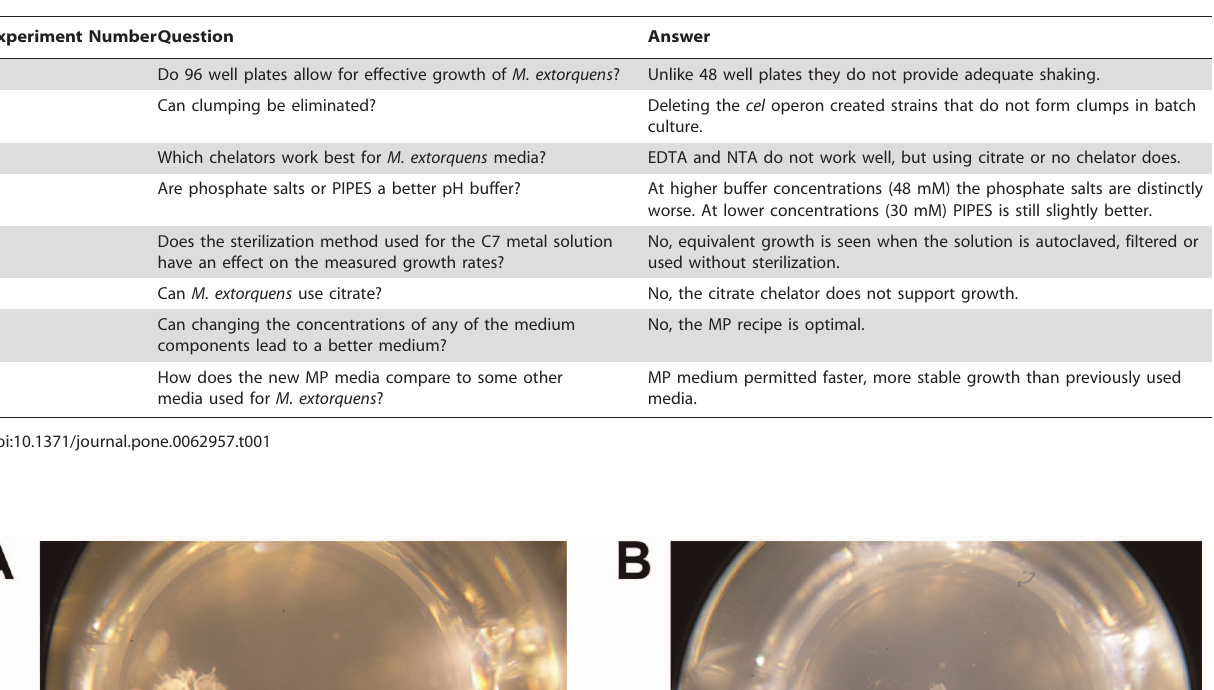
Table 1. Summary of experimental questions and findings.